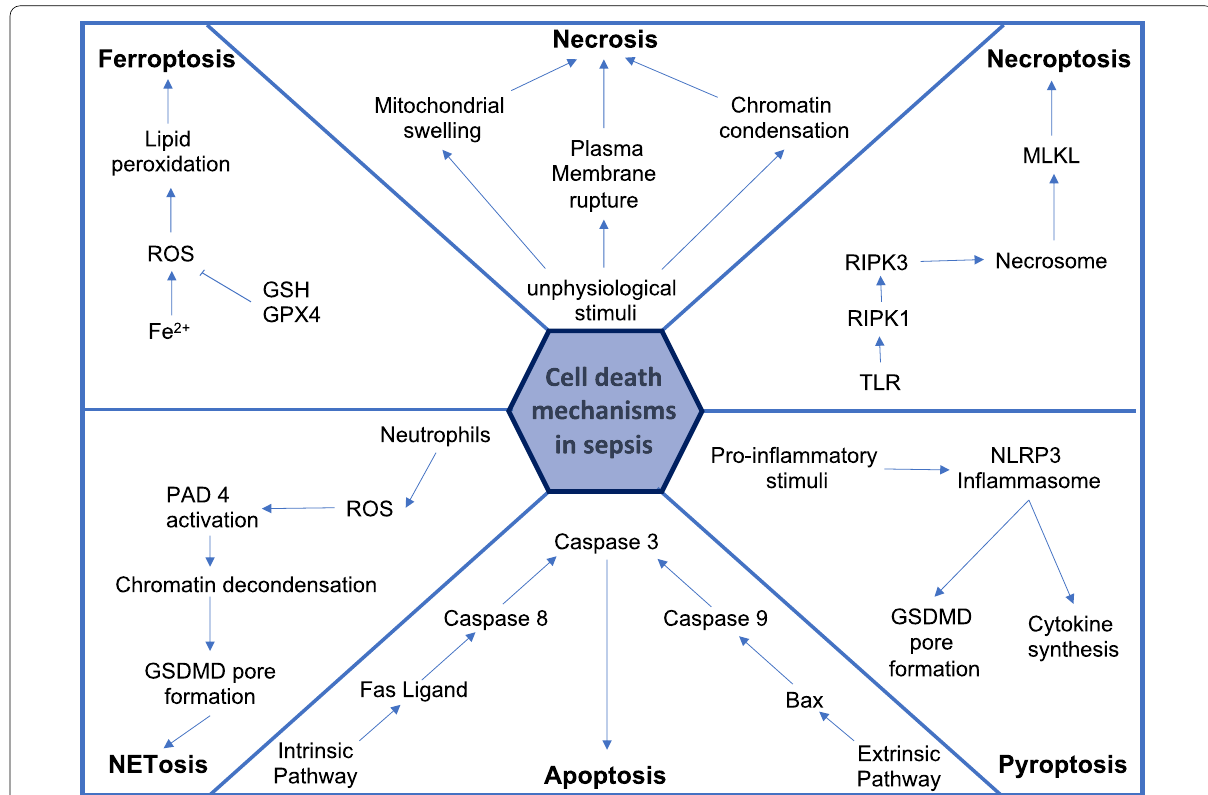
Fig. 2 Main cell death mechanisms. The liver harbors parenchymal cells and different immune cell populations that contribute to immune reaction till their death through a regulated cell death mechanism. Hepatocytes are classical apoptotic cells since their death due to toxic metabolites occurs naturally and should not trigger inflammation. Recently, oxidative-regulated cell death Ferroptosis had been highlighted in various liver injuries, including sepsis driving reactive oxygen formation and inflammation. Necroptosis and pyroptosis are carried out by multiple cells after, e.g., TNF- α stimulation and drive inflammation during liver infection. NETosis dying neutrophils leave a vast number of extracellular debris and nucleotide nets to trap and destroy microorganisms even after their death. Finally, mechanically or chemical destruction of cells is apparent due to liver hypoxia